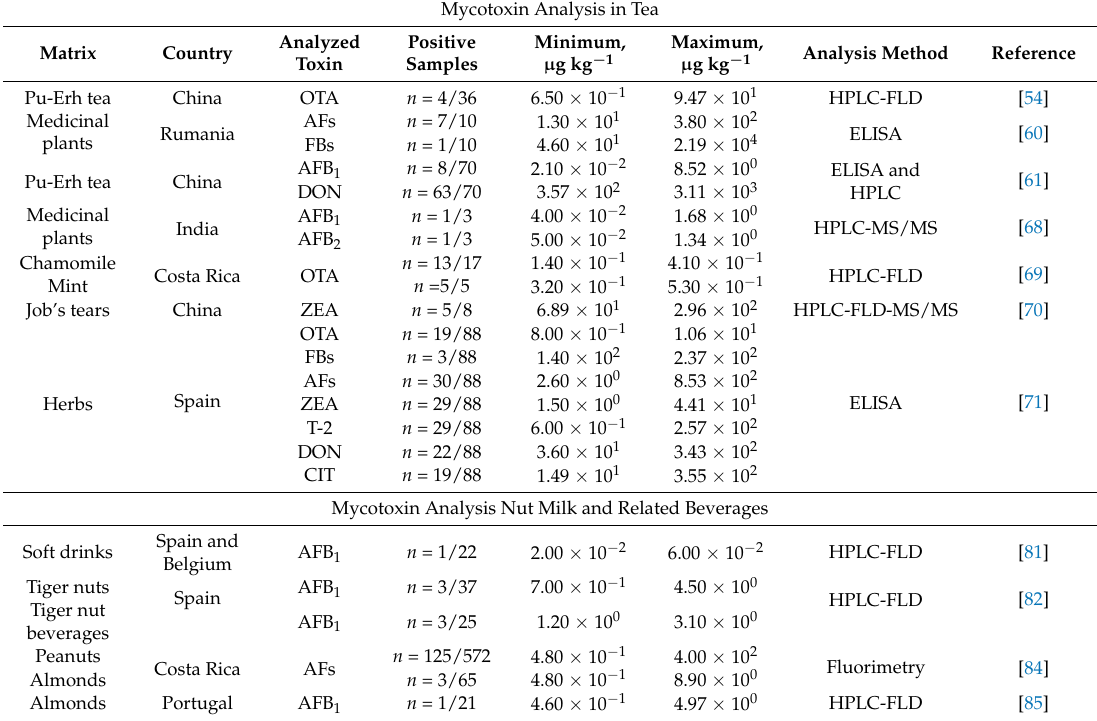
Table 2. Mycotoxin contamination found in herbal samples, nuts and nut-based